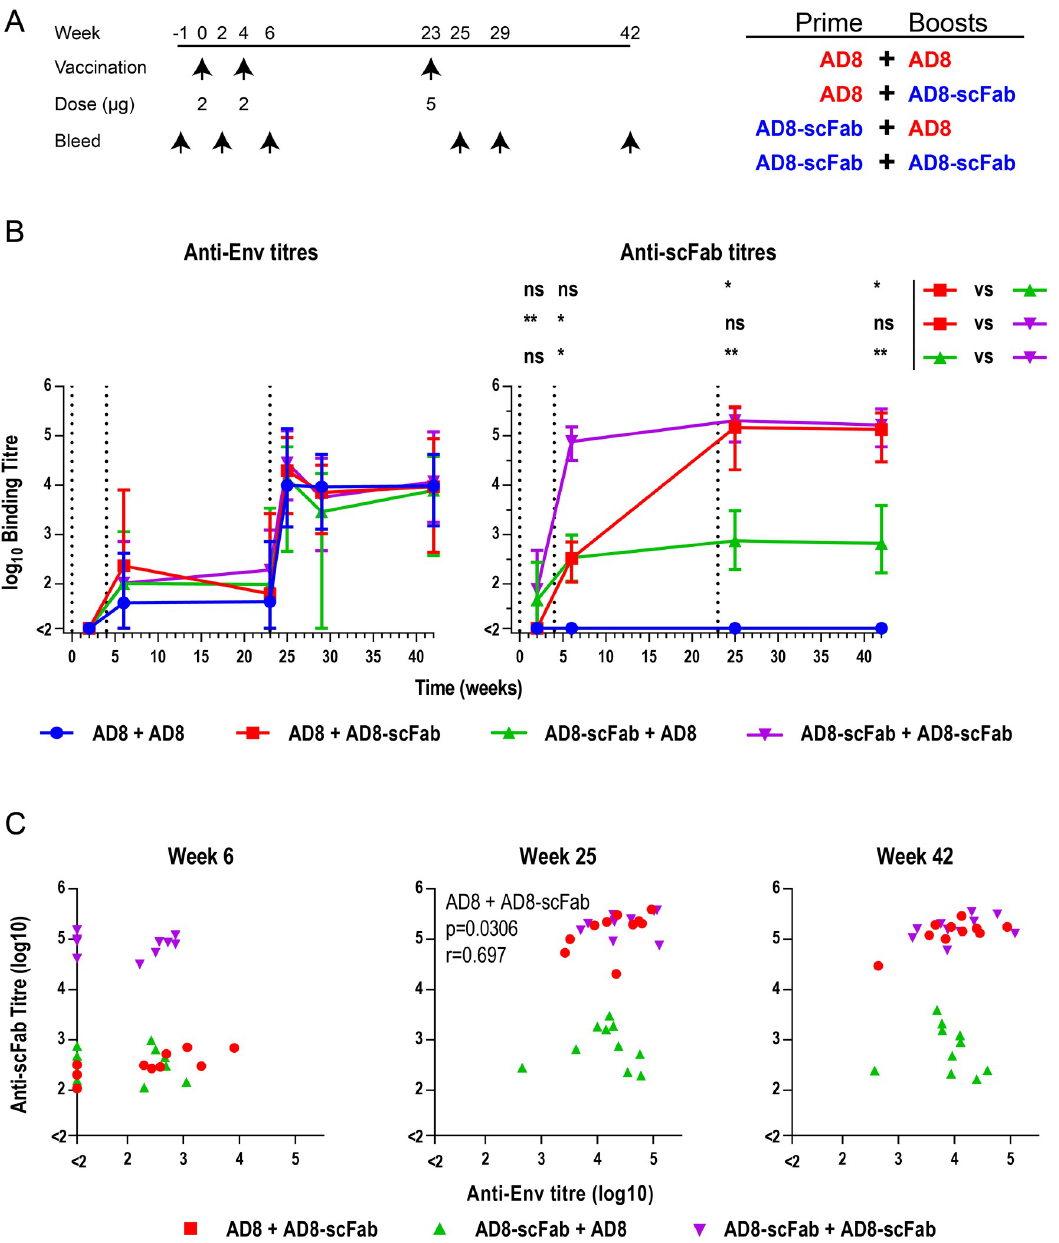
Fig 5. Antibody titers elicited by vaccination with Env-scFab. (A) Schematic of vaccination schedule and groups. (B) Anti-Env and anti-scFab titers in sera measured by ELISA. For anti-Env titers, 5 μ L/well of concentrated AD8 gp140 293T supernatant was captured onto the ELISA plate using D7324, then mouse sera were half-log serially diluted from an initial 1:100 dilution. For anti- scFab titers ELISA plates were coated with 10B4, then mouse sera were diluted in a half-log series. Titers were defined as the dilution at which the ELISA curve was equal to 3x the average of the adjuvant only group. Graph shows the mean of individual titers within each vaccination group, error bars represent the range and the vertical dotted lines indicating vaccination times. Significance was assessed using a Kruskal Wallis test, followed by a Dunn’s post-test, with � p < 0.05, �� p < 0.01 and ns not significant. (C) Correlations of anti-scFab and anti-Env titers at indicated time points. Correlations were assessed for groups that received the AD8-scFab immunogen using a Spearman